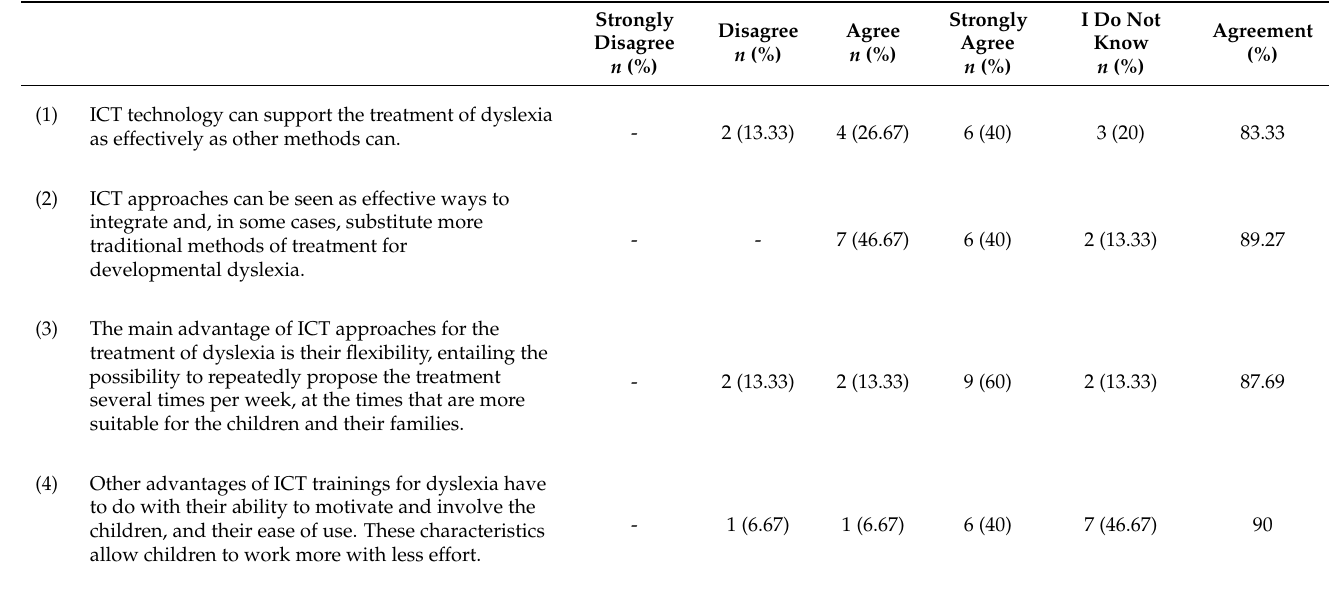
Table 2. Round 2 statements and overall degree of agreement (expressing the percentage of “agree” and “strongly agree” replies on total number of responses excluding “I do not know” responses). Number of responses and percentages (in parentheses) are reported for each